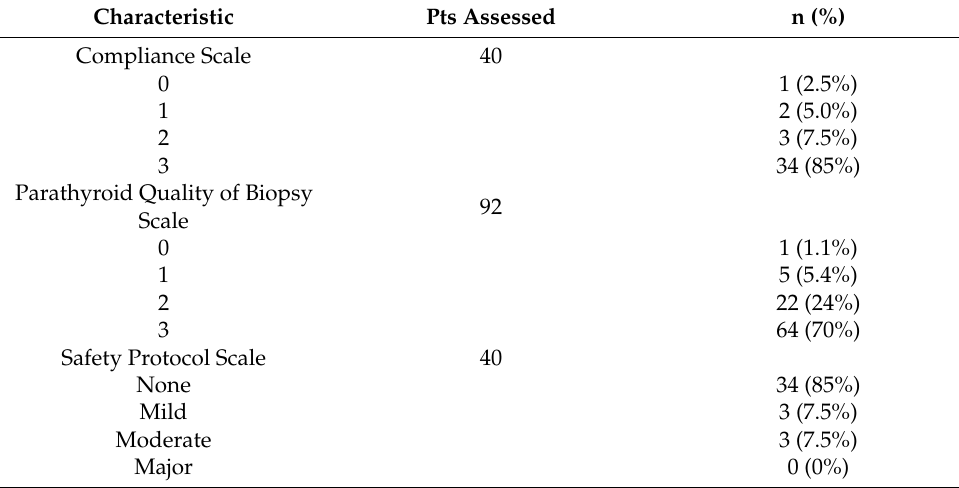
Table 3. Qualitative measures of P-FNAB performance.